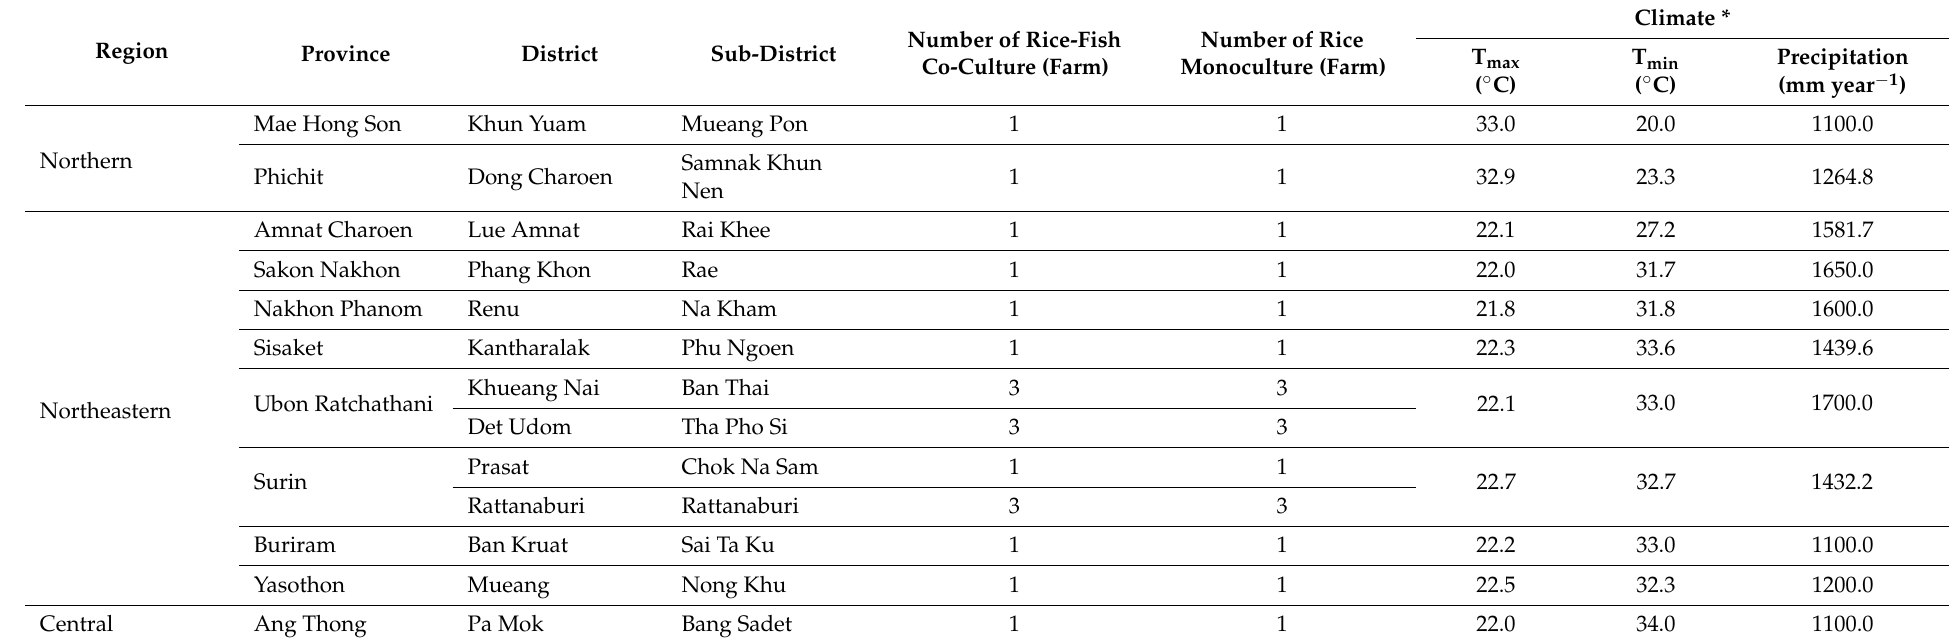
Table 1. Description of study